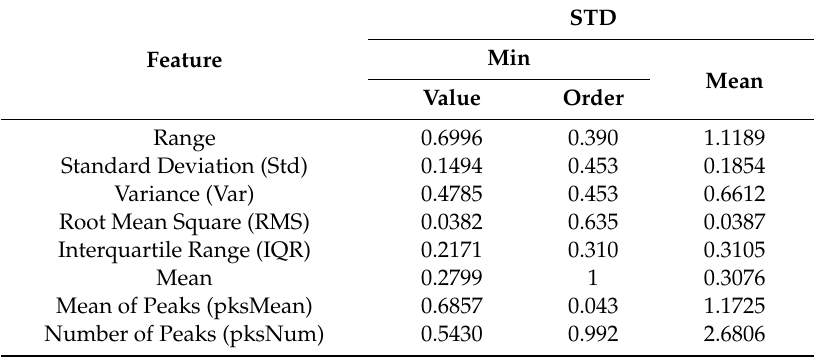
Figure 11. Standard deviation and mean of eight features of the run action. ( a ) The standard deviation of each feature, ( b ) The mean of each feature. Table 5. Mean and min of standard deviation of each feature of run.